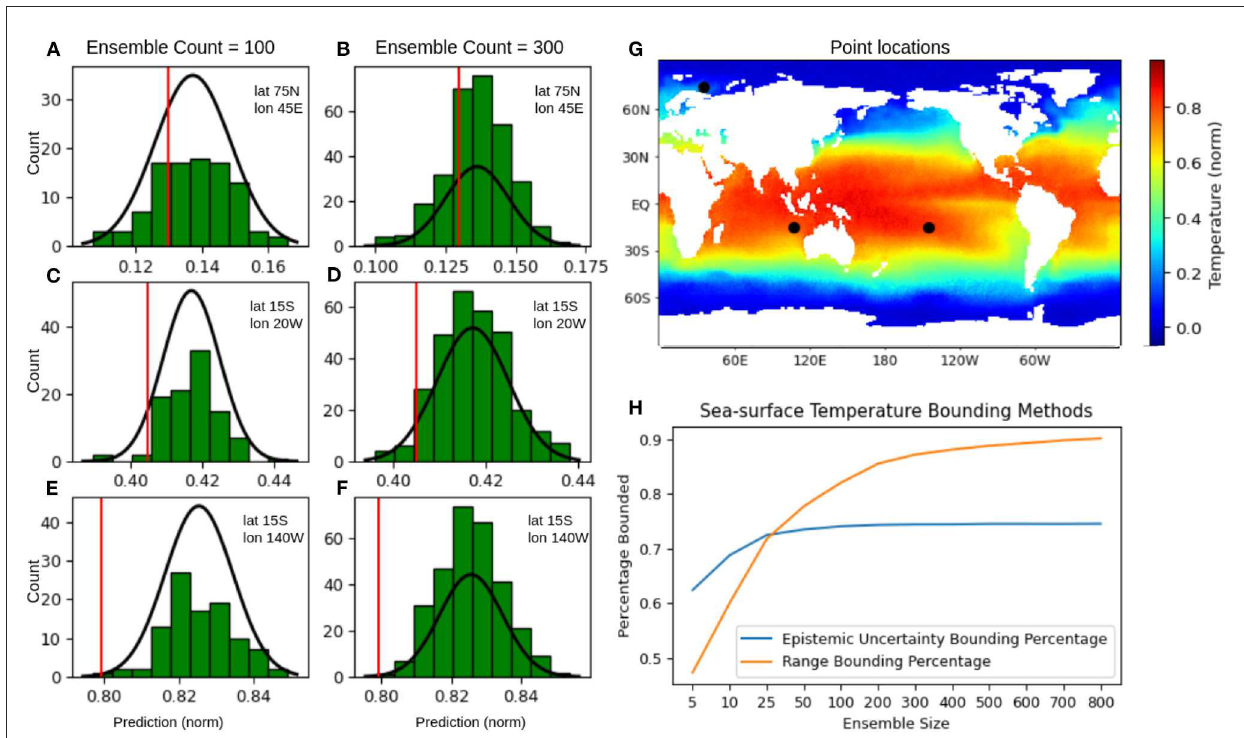
FIGURE7 Analysis of the predicted ensemble for three different pixels of a random test sample from the NOAA Sea-Surface Temperature (SST) example. (A–F) Show a histogram of the model predictions at the indicated lat, lon coordinate, with the target value for that pixel represented by the vertical red line, (G) shows the location of these pixels as black dots superimposed on the prediction field, and (H) shows a plot of the percentage of pixels where the error is bounded by the epistemic uncertainty (blue) or the percentage of points where the target value lies within the range of ensemble predictions (orange) over the entire SST test